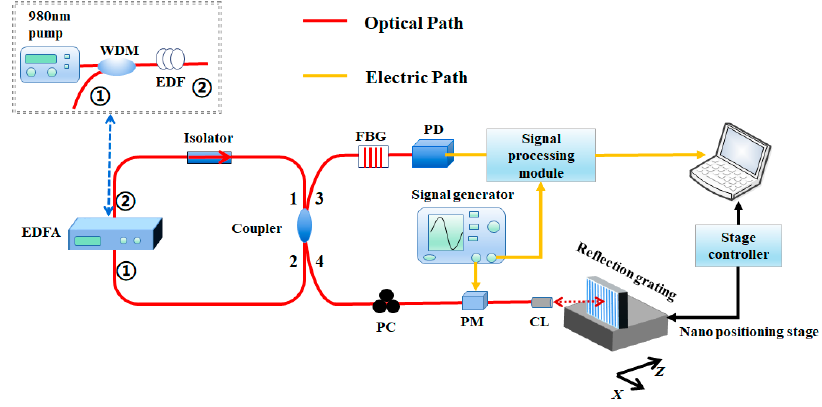
Figure 4. Experimental setup of an all- fi ber LFI for displacement sensing .